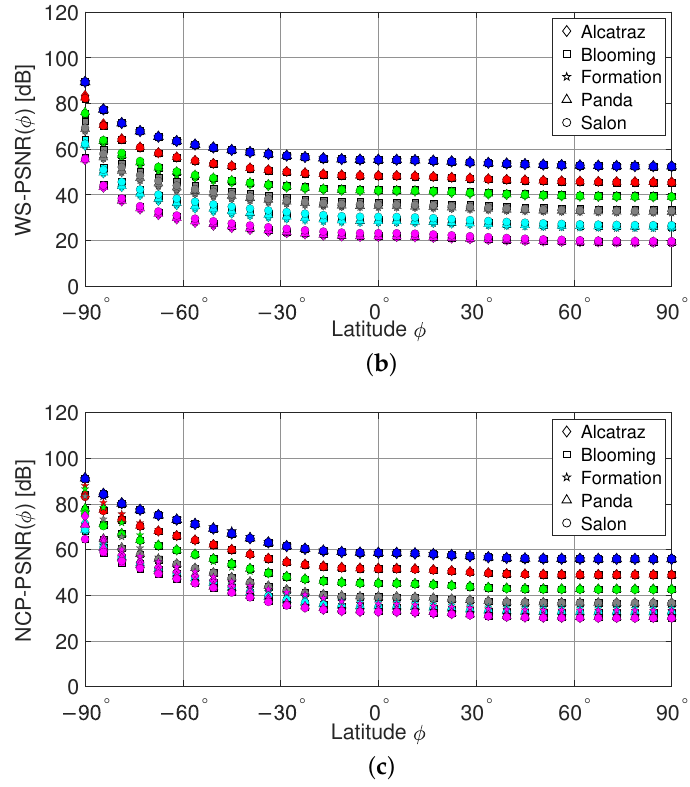
Figure 16. Fidelity of viewing direction based LSB data hiding in the latitude: ( a ) PSNR( φ ), ( b ) WS- PSNR( φ ), ( c ) NCP-PSNR( φ ).